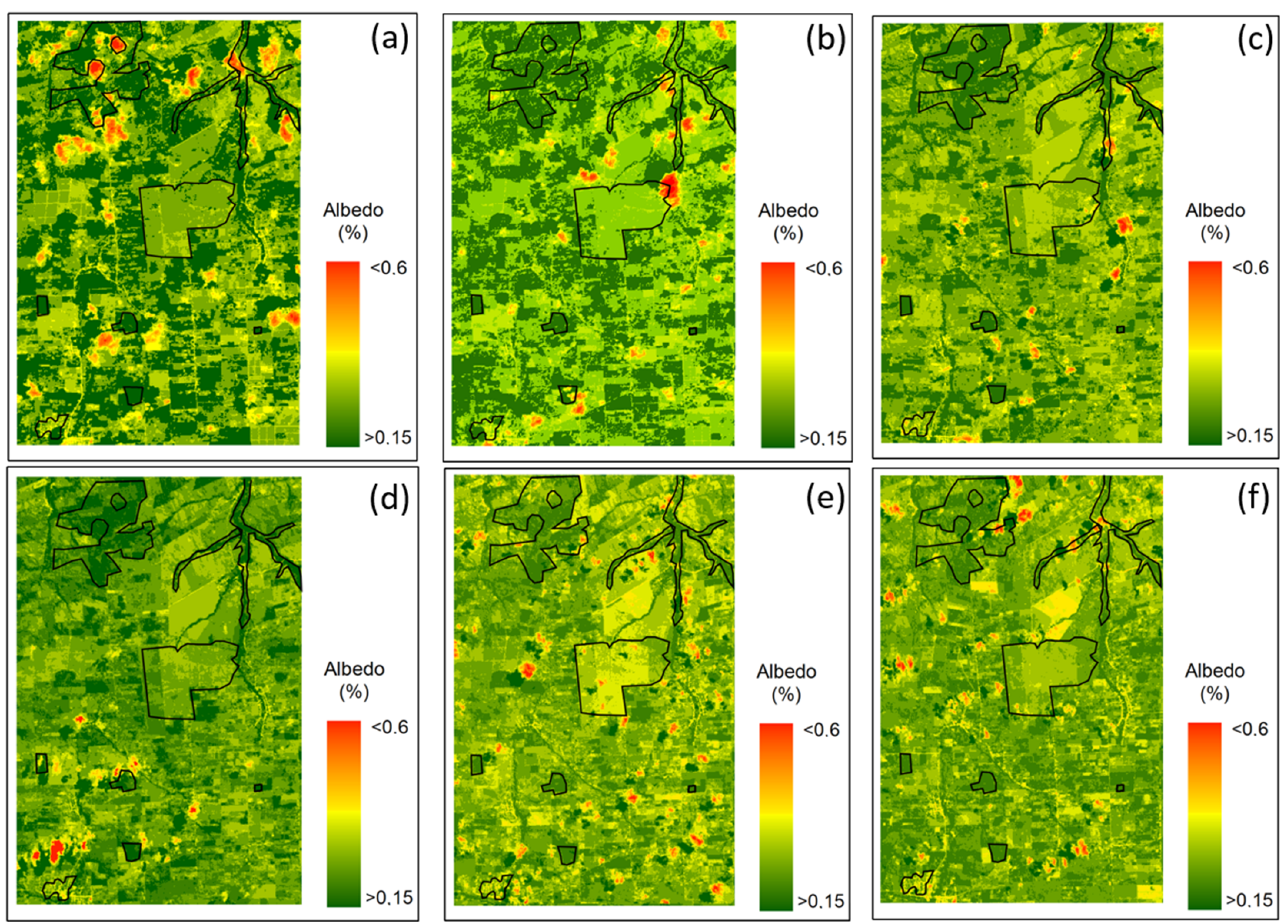
Figure 5. Temporal distribution of albedo ( α ) on 20 November 2017 ( a ), 22 December 2017 ( b ), 31 May 2018 ( c ), 7 June 2018 ( d ), 26 June 2019 ( e ), and 29 August 2019 ( f ).